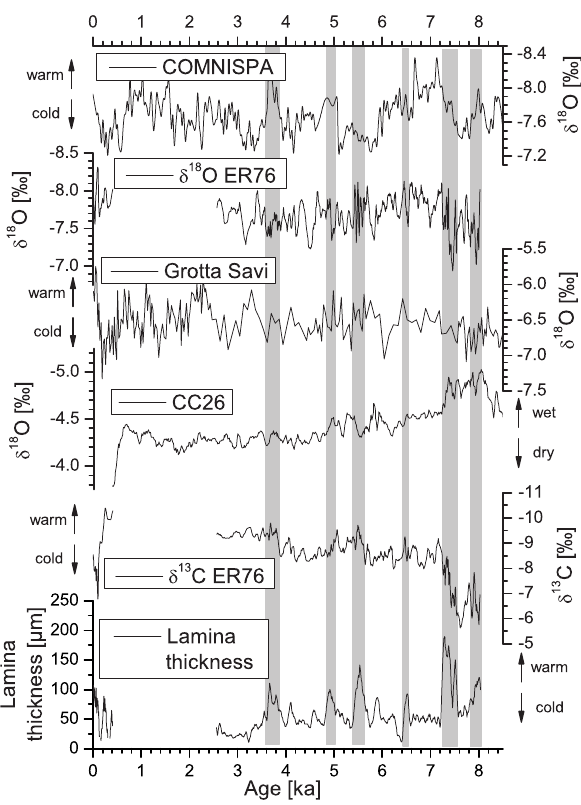
Fig. 7. Comparison of the stable isotope and lamina thickness records of ER 76 with the δ 18 O record of stalagmite CC26 from Corchia cave (central Italy, Zanchetta et al., 2007), the δ 18 O record of stalagmite SV1 from Grotta Savi (northern Italy, Frisia et al., 2005) and a speleothem δ 18 O record from the Austrian Alps (COM- NISPA, Vollweiler et al., 2006). All records are dated by U-series methods, and each record is plotted on its own time scale. Note that the y-axis scales of all stable isotope records except for that of stalagmite SV1 are inverted. Arrows next to the individual records indicate the relationship between the corresponding proxy and cli- mate. Phases of warm winter climate at Grotta di Ernesto, as indi- cated by positive peaks in lamina thickness and negative peaks in δ 13 C, are highlighted in light